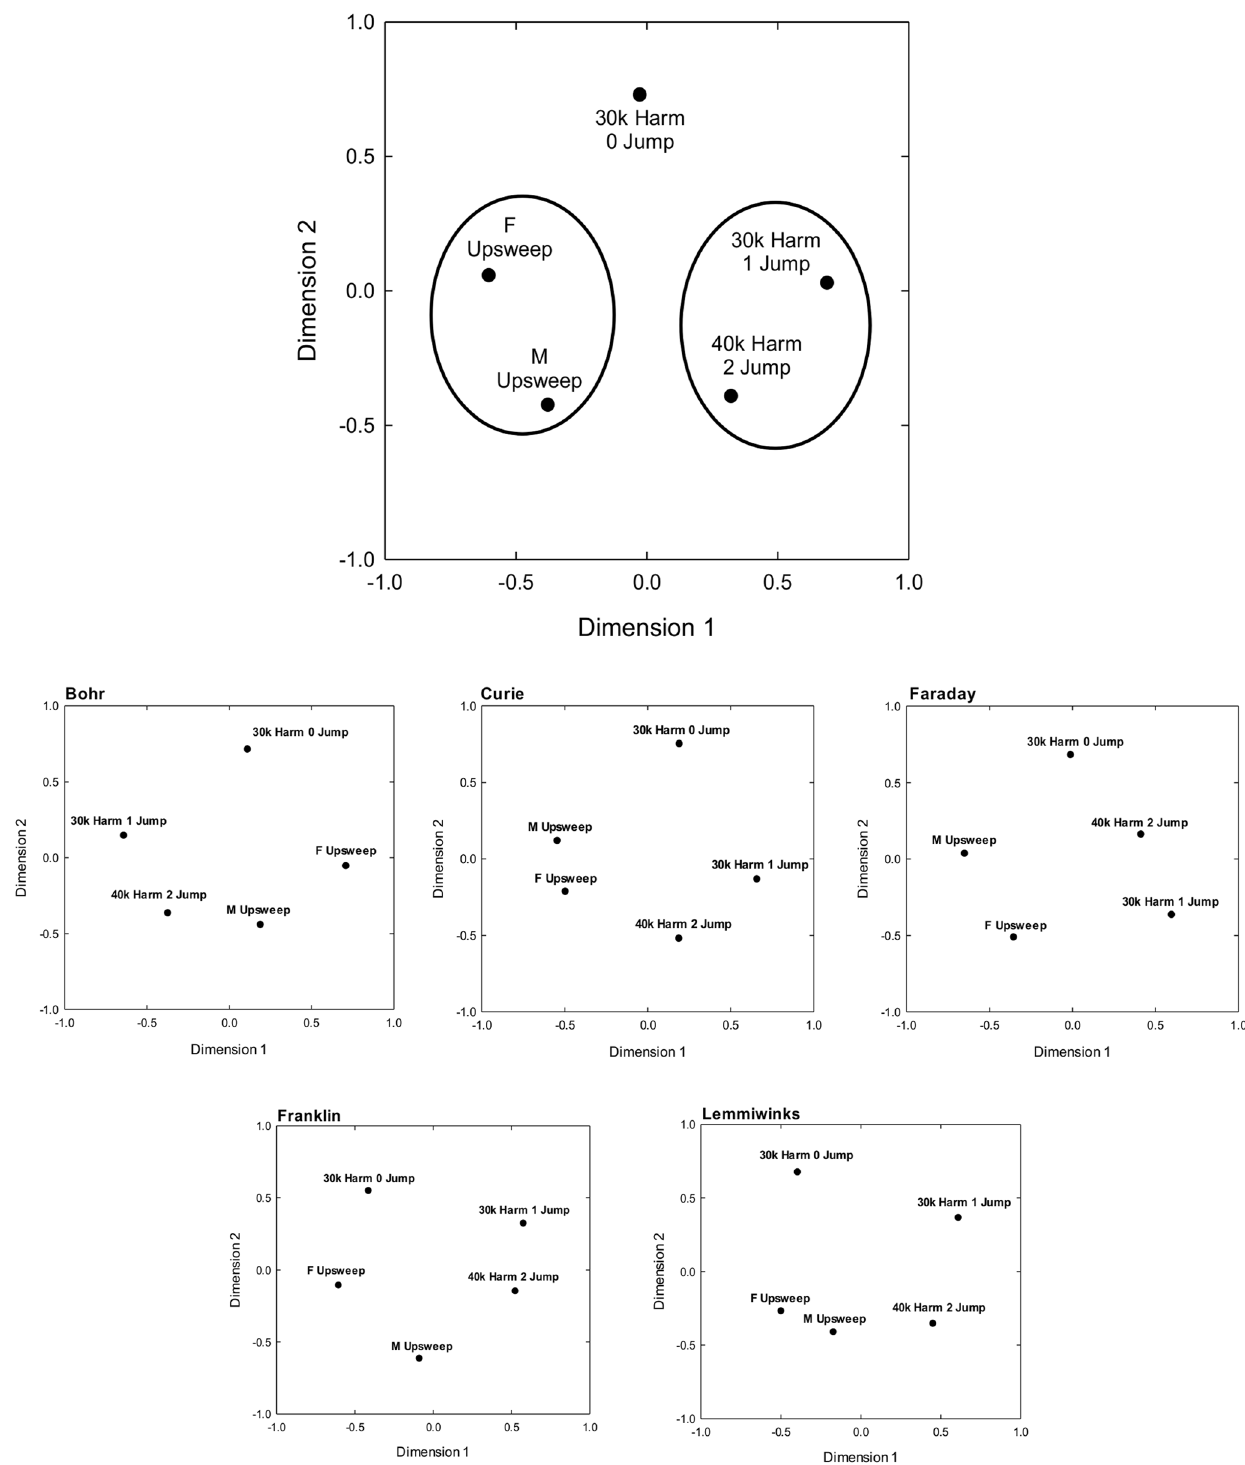
Figure 3. Multidimensional analysis of vocalization discrimination. At the top, multidimensional map of mean vocalization discrimination obtained from matrices of discrimination performance for the five vocalization types. Circles connect vocalizations with the two smallest Euclidian distances. At the bottom are the five individual perceptual maps generated for each mouse across the five vocalization types.